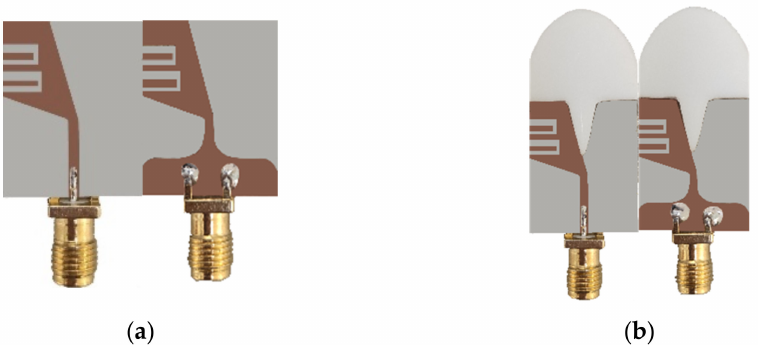
Figure 8. Photographs of fabricated single antenna element, ( a ) TSA and ( b ) TSA+DL. Both sides of each antenna sample are shown in the figure, and the same form is used in Figures 6b and